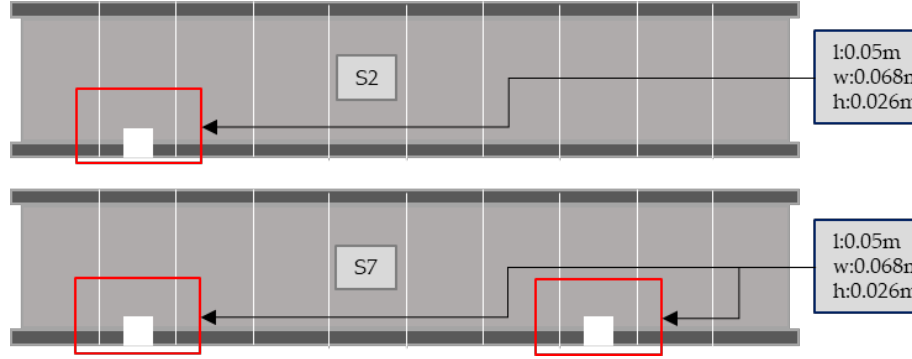
Figure 12. The notch position and size diagram.